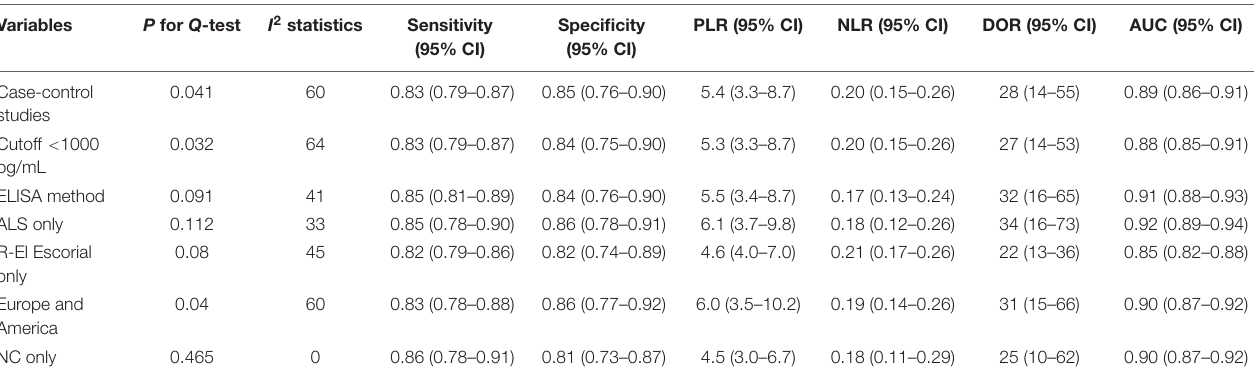
TABLE 3 | Results of subgroup analyses for